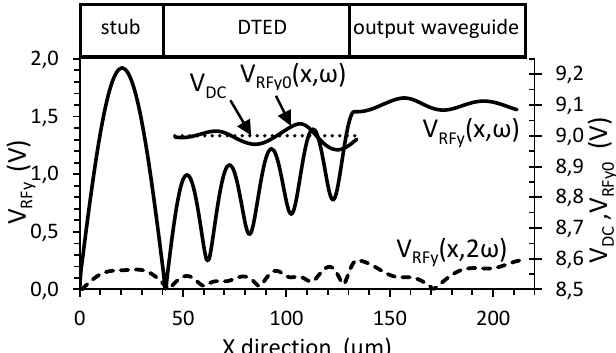
Figure 13: X direction evolution of the mean and RF voltage V RFy and DC bias voltage V DC